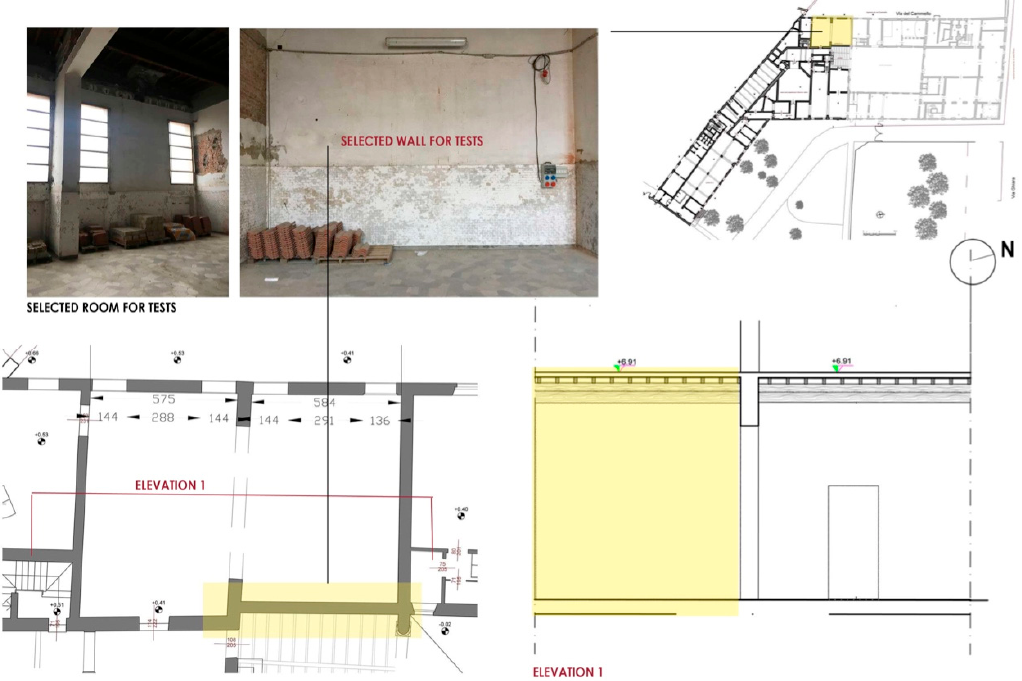
Figure 2. Ground floor plan of Palazzo Tassoni and signaling of the location of the room and wall on which the experiment is carried out (in yellow). Internal views of the room. Inside elevation of the wall (in yellow).